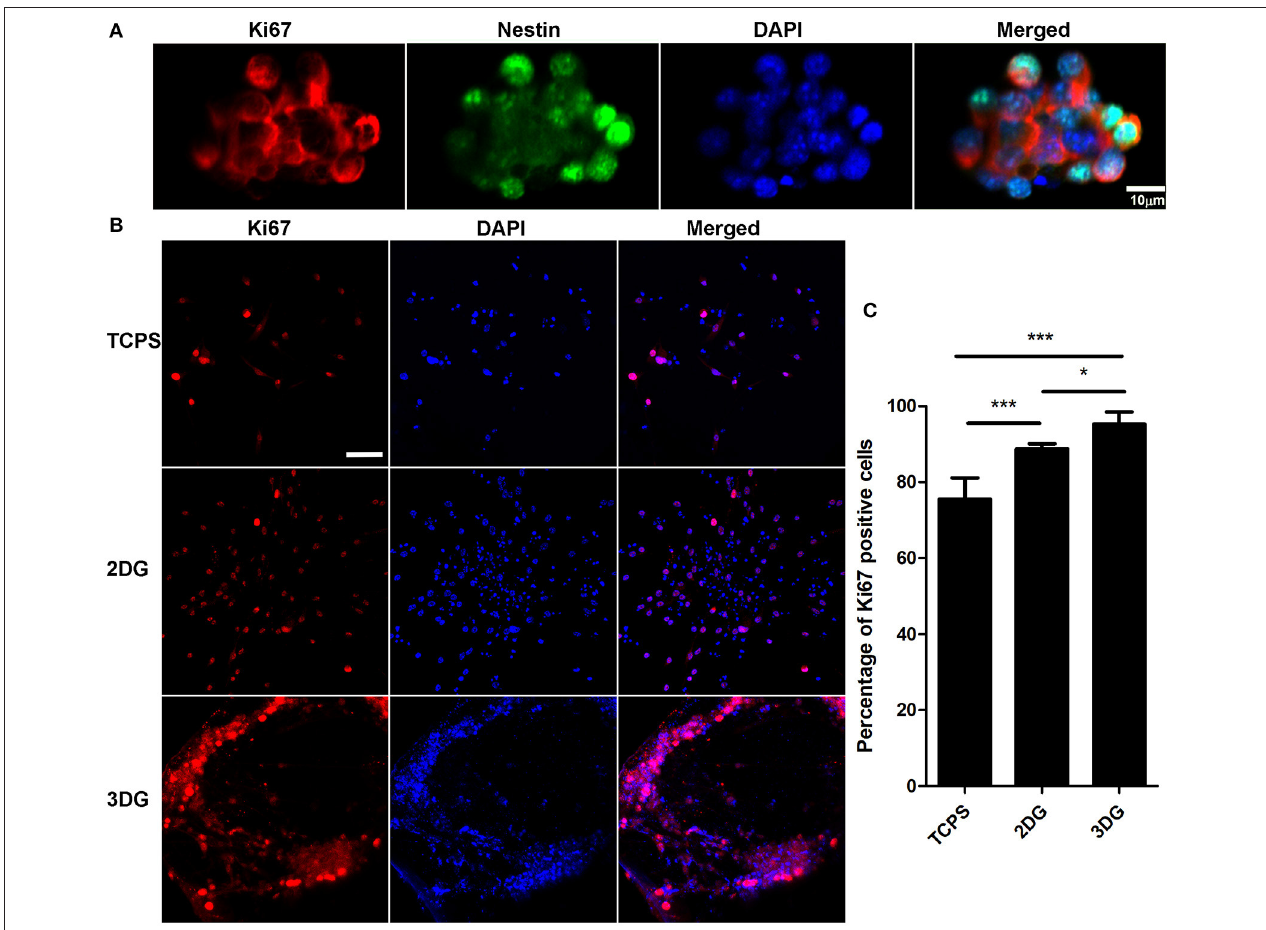
FIGURE 2 | Proliferation of NSC. (A) Immunostaining image of NSC spheres, scale bar = 10 µ m. (B) Proliferation detected after 5 days culture using Ki-67 immunolabeling, nuclei were labeled using DAPI. Scale bar = 50 µ m. (C) Quantification data of (B) shows percentage of Ki-67 positive cells among three groups. n = 5, data were shown as mean ± SD, * p < 0.05, *** p <